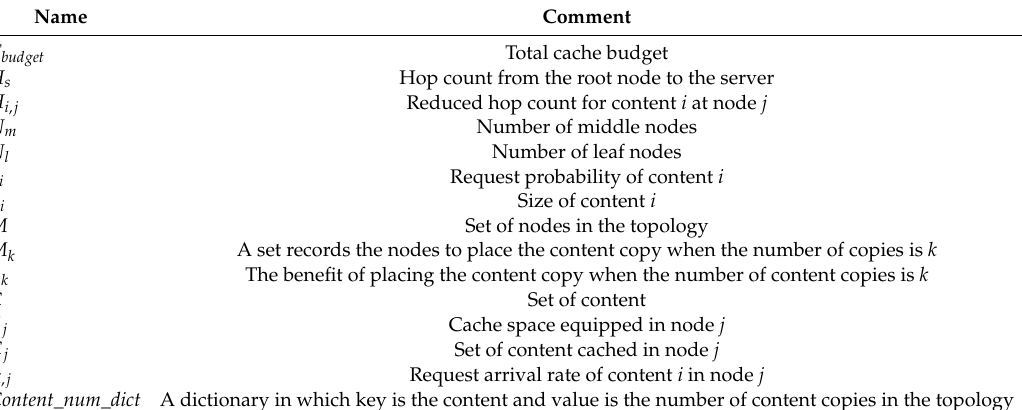
Table 1. Summary of the notations.